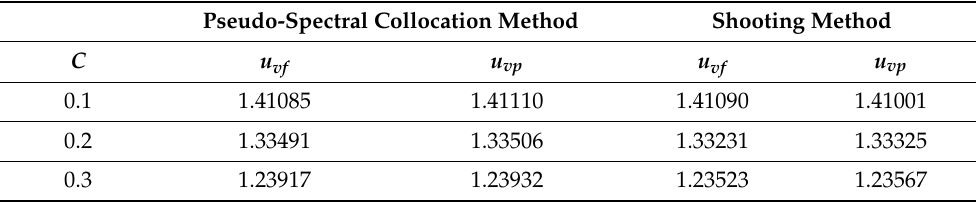
Table 2. Absolute error between shooting method and pseudo-spectral collocation